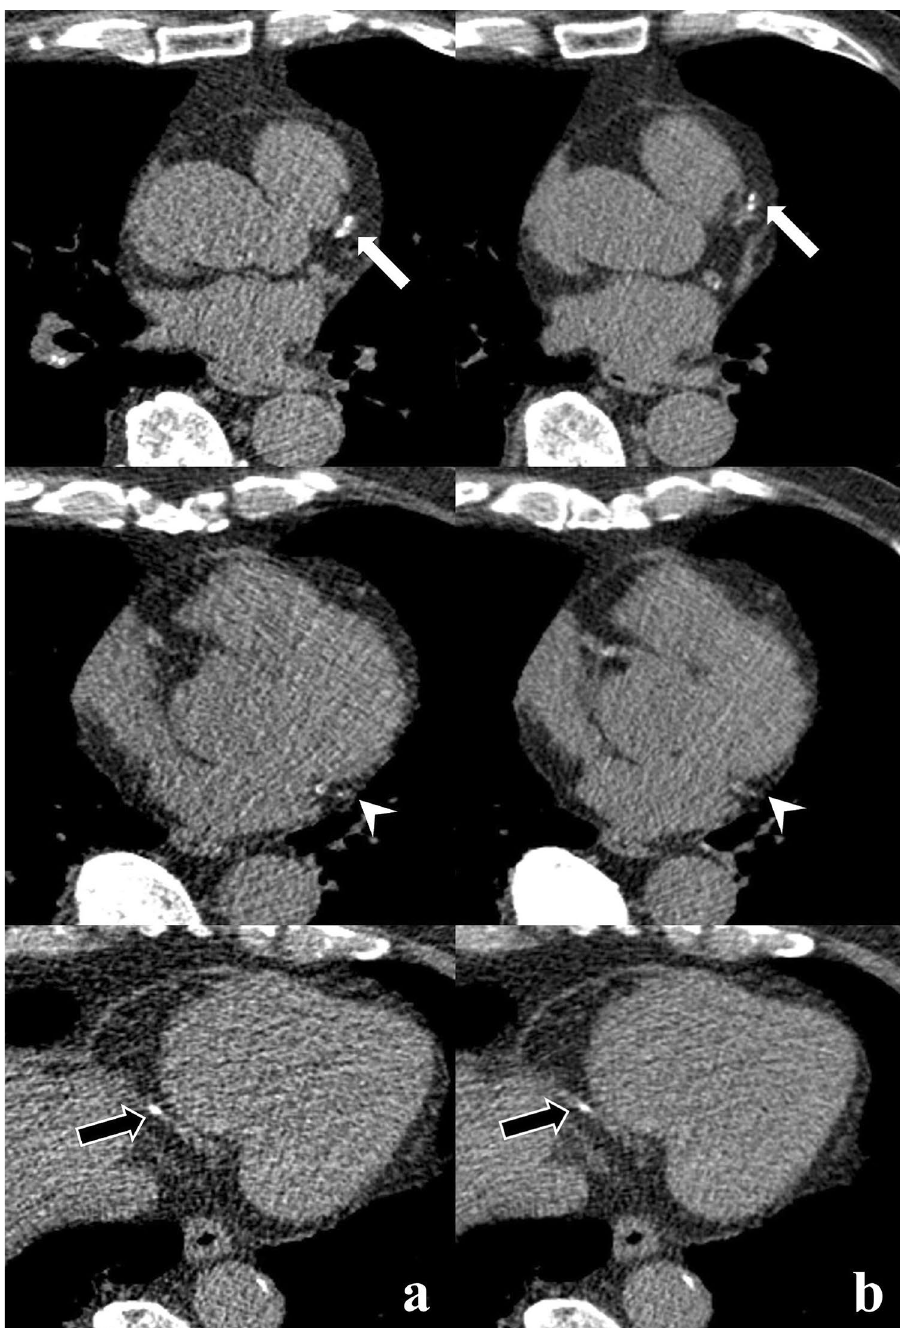
Figure 1. An 80-year-old male with 2-vessel CAD and moderate CAC on 1.5 mm (CAC score, 354.8) and 3 mm (CAC score, 243.0) slice thickness reconstructions. Images from a 1.5 mm slice thickness ( a ) and 3 mm slice thickness ( b ) at the corresponding scan level are shown. Calcified plaques in the left anterior descending artery (white arrow), left circumflex artery (white arrowhead), and distal right coronary artery (black arrow) are more evident in the 1.5 mm slice thickness reconstruction. The patient underwent revascularization by PCI after 272